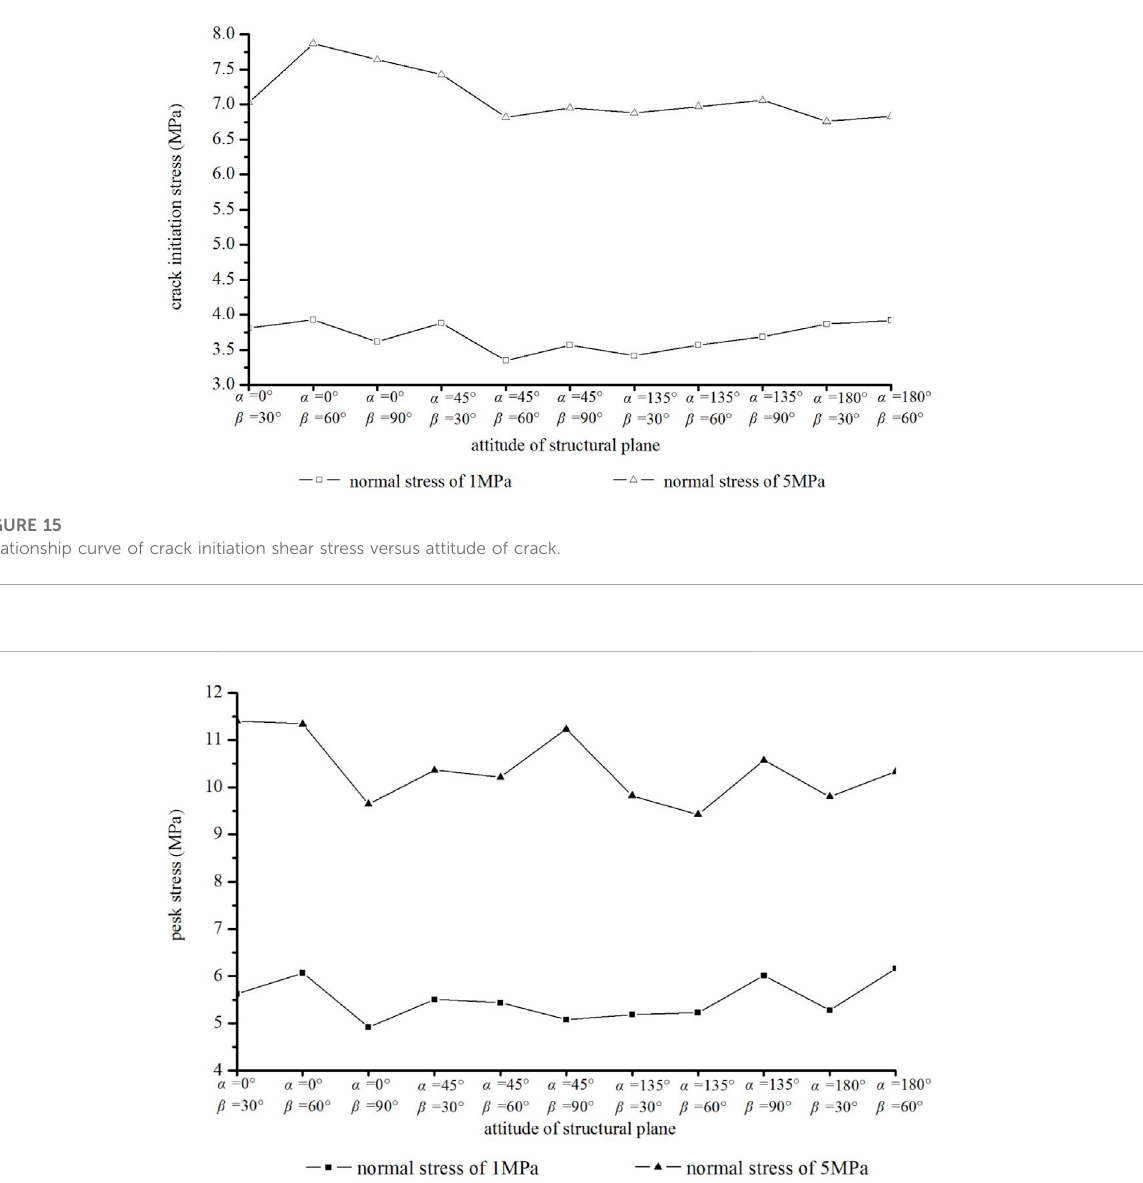
FIGURE 16 Relationship curve of peak shear stress versus attitude of